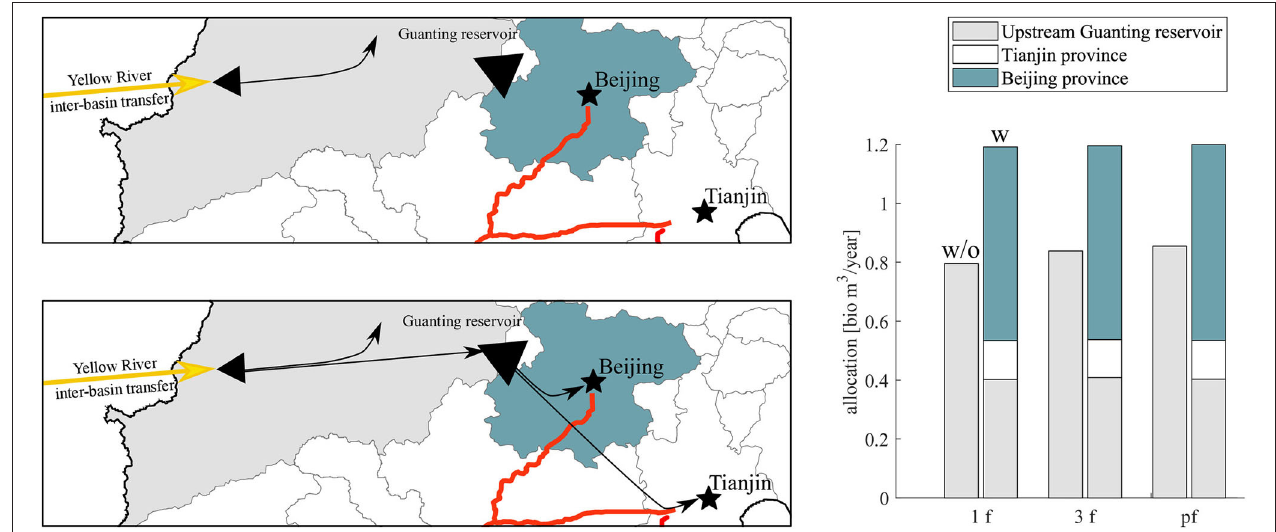
FIGURE 9 | Left upper and lower figure shows the major flow path of the Yellow river inter-basin transfers without (w/o) and with (w) the water infrastructure project, respectively. Right bar plot shows the optimal sub-basin allocations for the Yellow River inter-basin transfers without and with the project, and for the 1f, 3f, and pf foresight